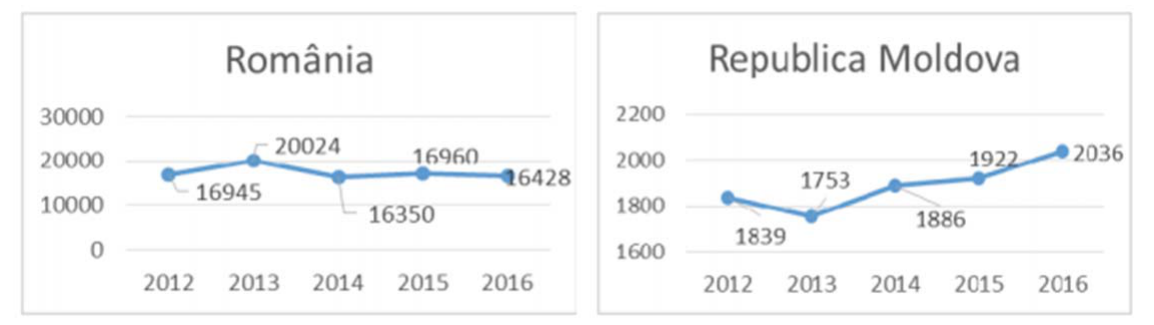
Figure 1 . The number of children born prematurely during 5 years (2012 –